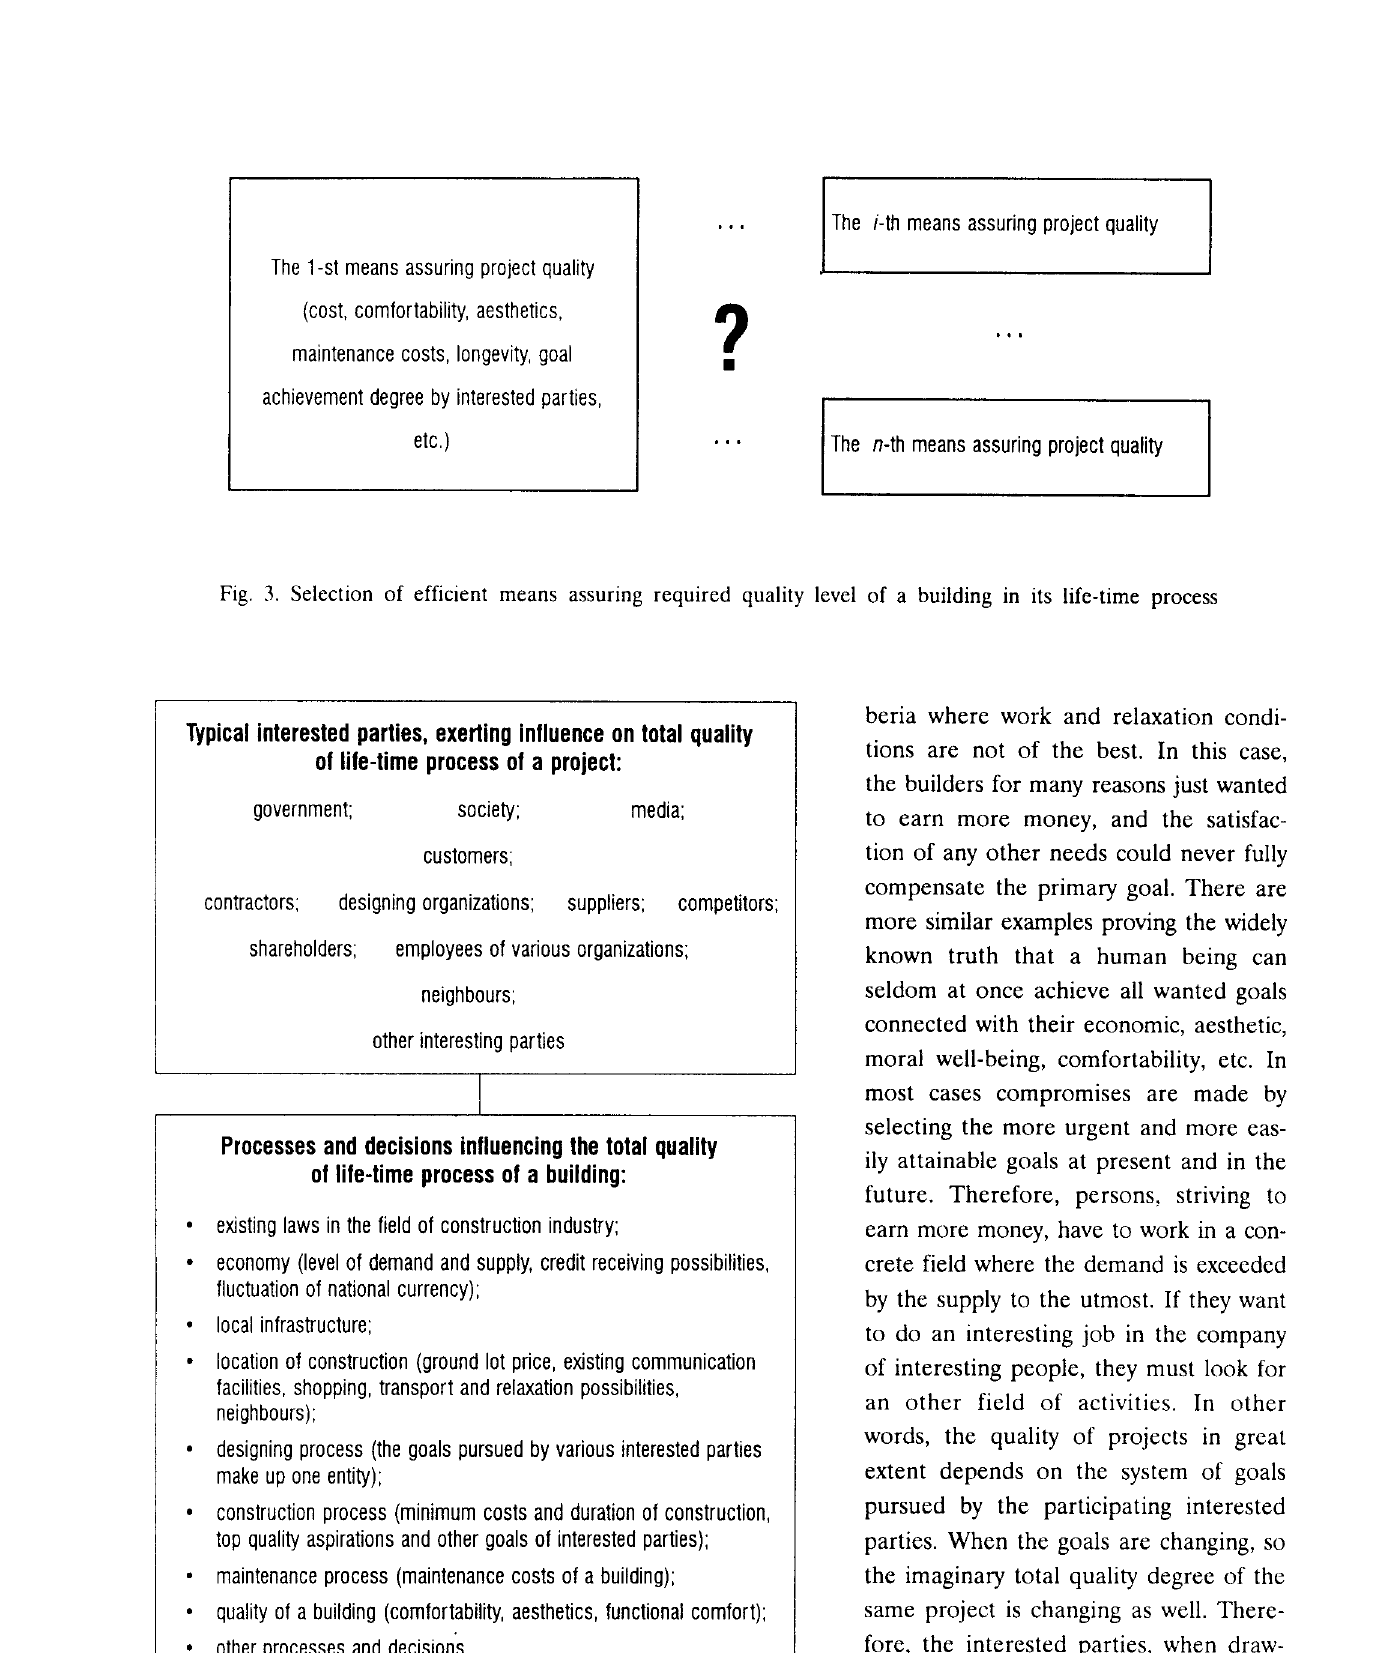
Fig. 4. Factors influencing the total